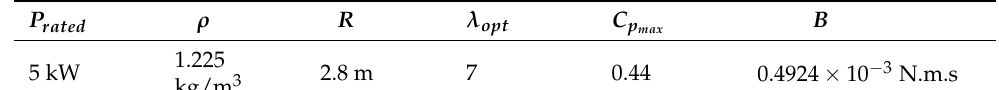
Table 2. Parameters of PMVG-based WECS [43].